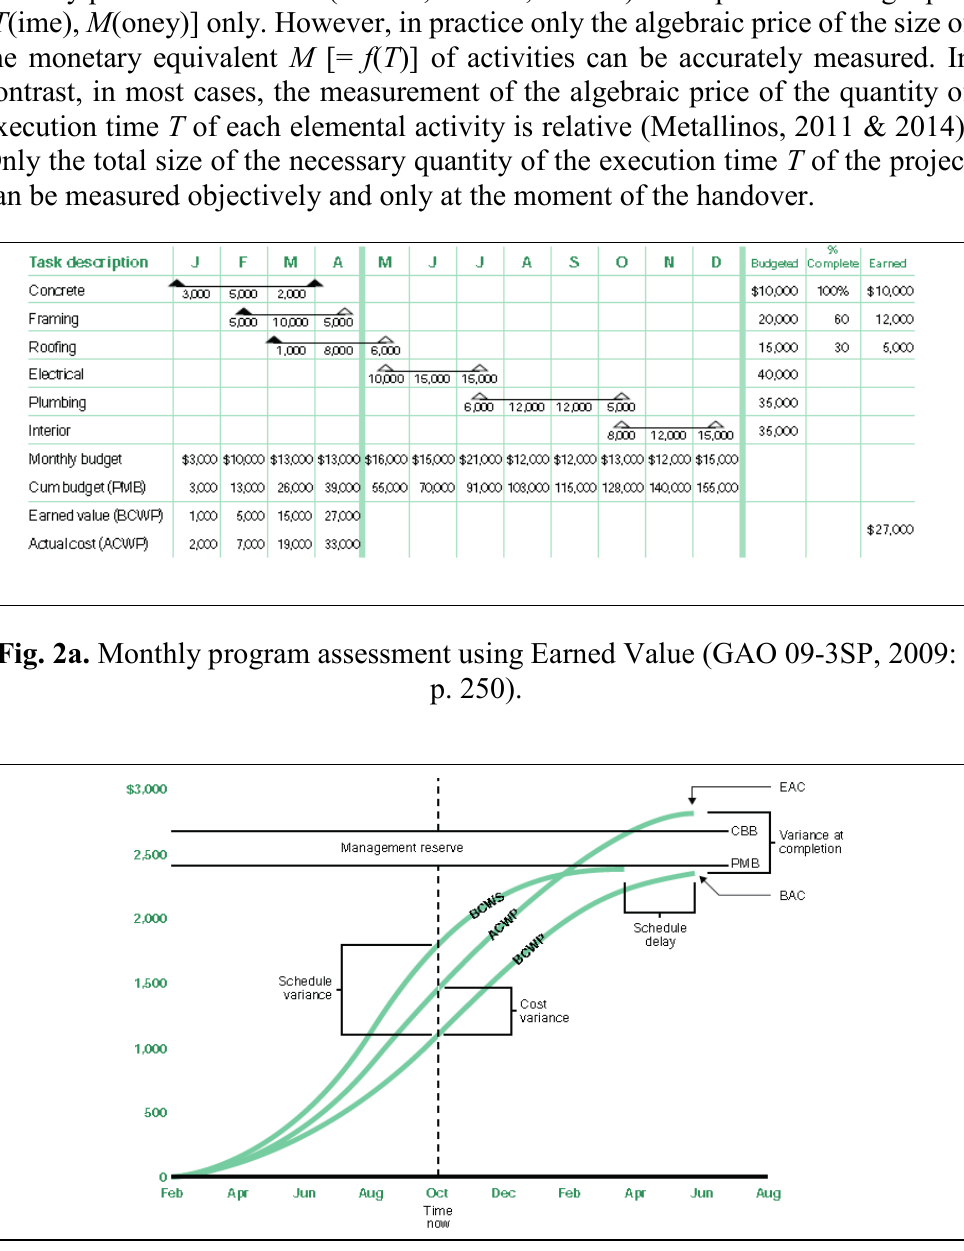
Fig. 2b. Overall program view of EVM data (GAO 09-3SP, 2009: